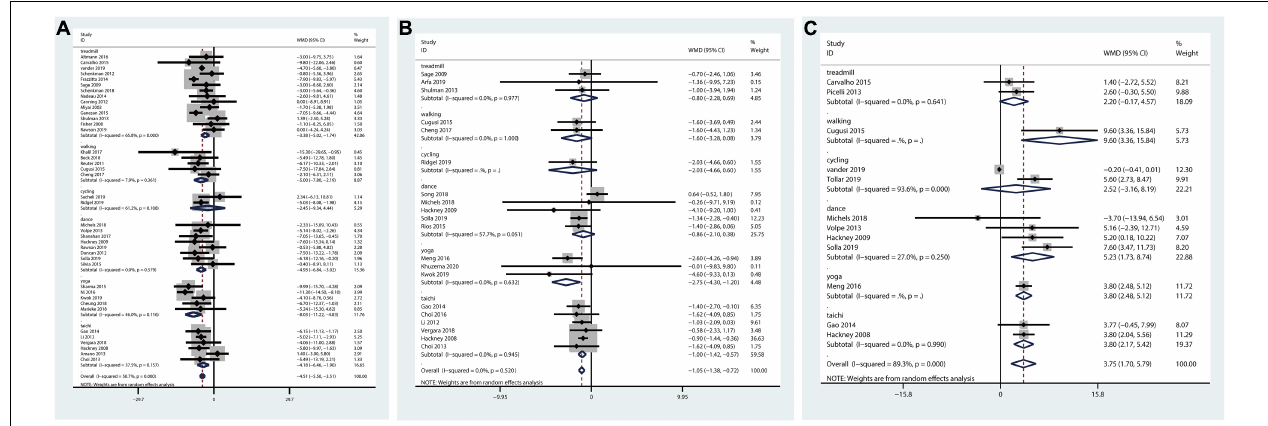
FIGURE 1 | Pairwise meta-analysis of aerobic and mind-body therapies on motor outcomes. (A) UPDRS-motor outcome. (B) TUG outcome. (C) BBS outcome. Meta-analysis results for pair-wise comparisons represented by MD and 95% credible interval (CrI).